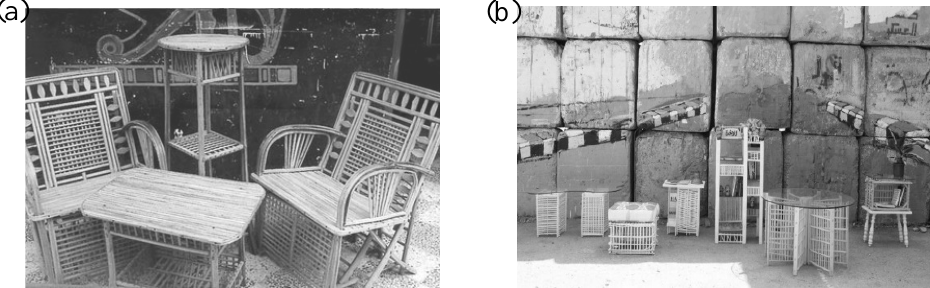
Figure 4. (a) Photographs of traditional palm leaves furniture (b) Studio Meem furniture